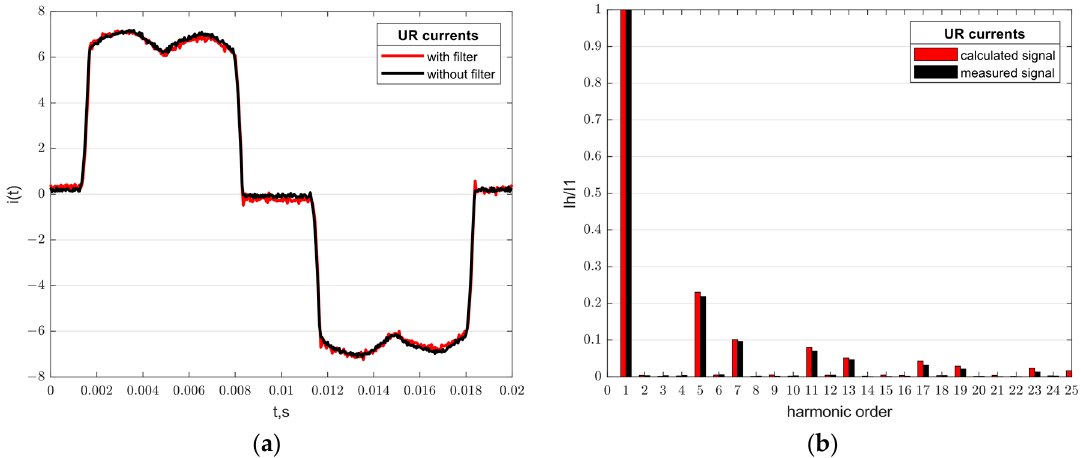
Figure 8. The waveforms ( a ) and harmonic spectrum ( b ) of UR currents.